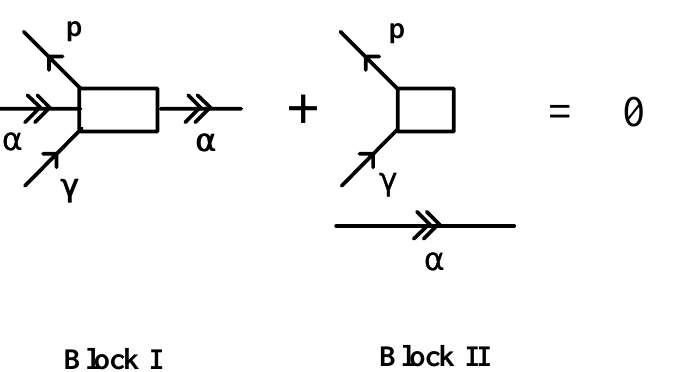
Figure 4: Block equation for pseudo-two-body excitations with spectator scattering line α . γ can take on labels β and α , leading to eqs. (28) and